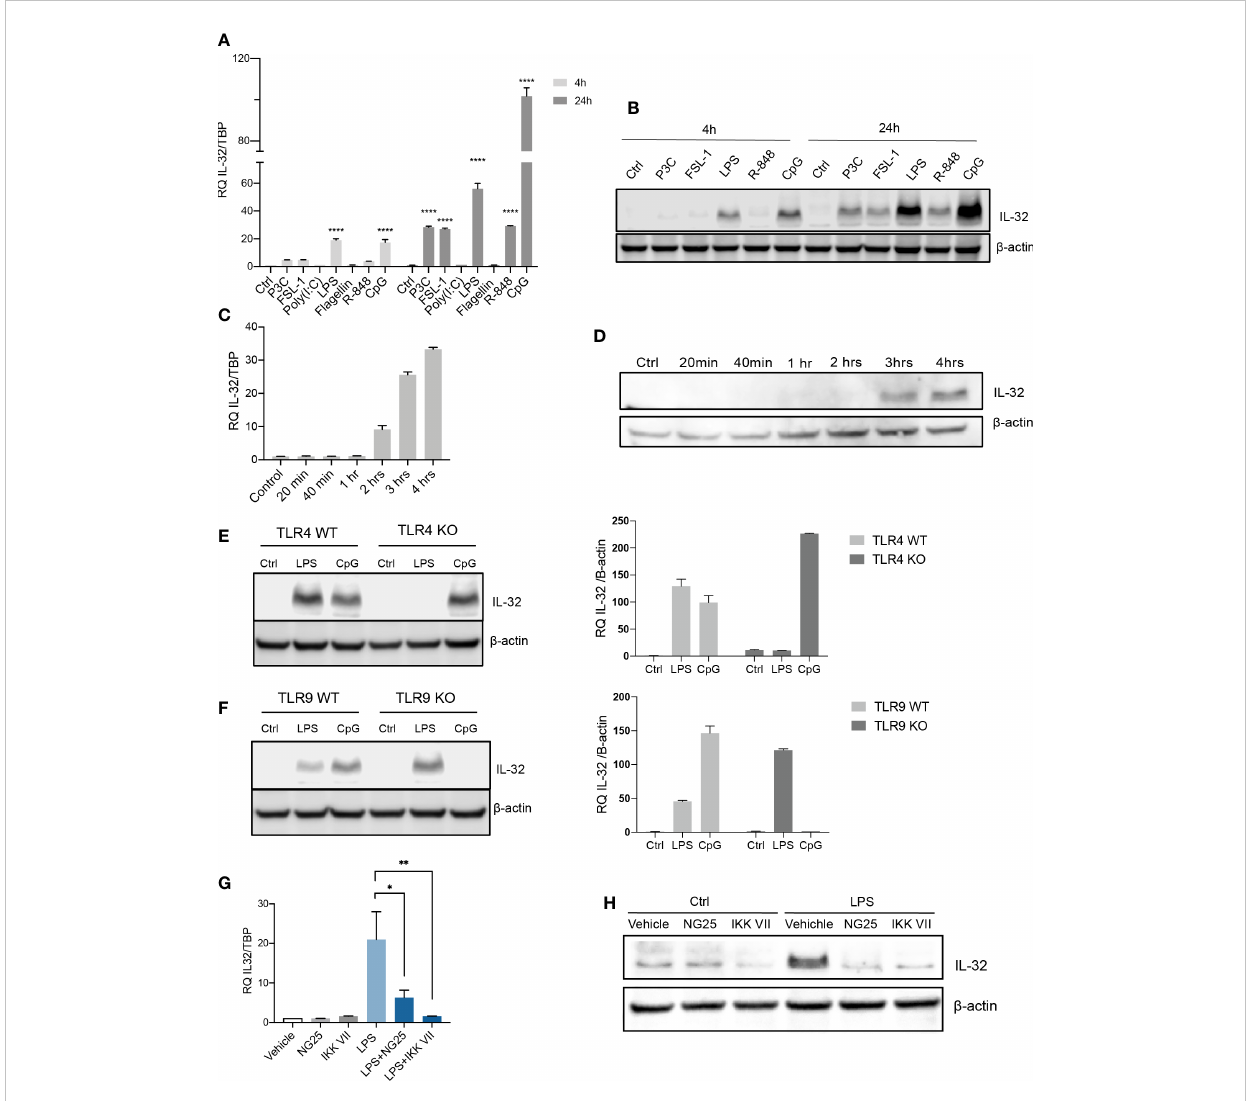
FIGURE 1 TLR-induced NF k B signaling promotes IL-32 expression in MM cells. (A) RPMI-8226 cells were stimulated with TLR agonists (for concentrations, see methods) for 4 and 24 hours and IL-32 mRNA expression was assessed by qPCR. The fi gure shows mean ± SEM of 3 independent experiments. (B) RPMI-8226 cells were stimulated with TLR agonists for 4 and 24 hours and IL-32 protein expression was evaluated by western blot. The fi gure shows representative western blot of 3 independent experiments. (C) RPMI-8226 cells were harvested at different time-points following LPS stimulation (0.1 µg/mL) and IL-32 mRNA expression was analyzed by qPCR (mean ± SD) and (D) IL-32 protein expression by western blot (E) RPMI- 8226 TLR4 WT (mock) and KO cell lines were stimulated with LPS and CpG for 24 hours. Figure shows representative western blot (n=3) of IL-32 protein and qPCR analysis of IL-32 mRNA (mean ± SD, n=1) (F) RPMI-8226 TLR9 WT (mock) and KO cell lines were stimulated with LPS and CpG for 24 hours. The fi gure shows representative western blot (n=2) of IL-32 protein and qPCR analysis of IL-32 mRNA (mean ± SD, n=1) (G) RPMI-8226 cells were stimulated with LPS (0.1 µg/mL) and NG25 (2 µM) or IKK VII (10 µM) for 4 hours. IL-32 mRNA expression (mean ± SEM, n=3) was assessed by qPCR. (H) RPMI-8226 cells were stimulated with LPS, NG25 and IKK VII (concentrations as above) for 4 hours. The fi gure shows representative western blot (n=3) of IL-32 protein expression. P-values in (A) and (G) are calculated by one-way ANOVA with Dunnett´s multiple comparison test. *p ≤ 0.05, **p ≤ 0.001, ****p ≤